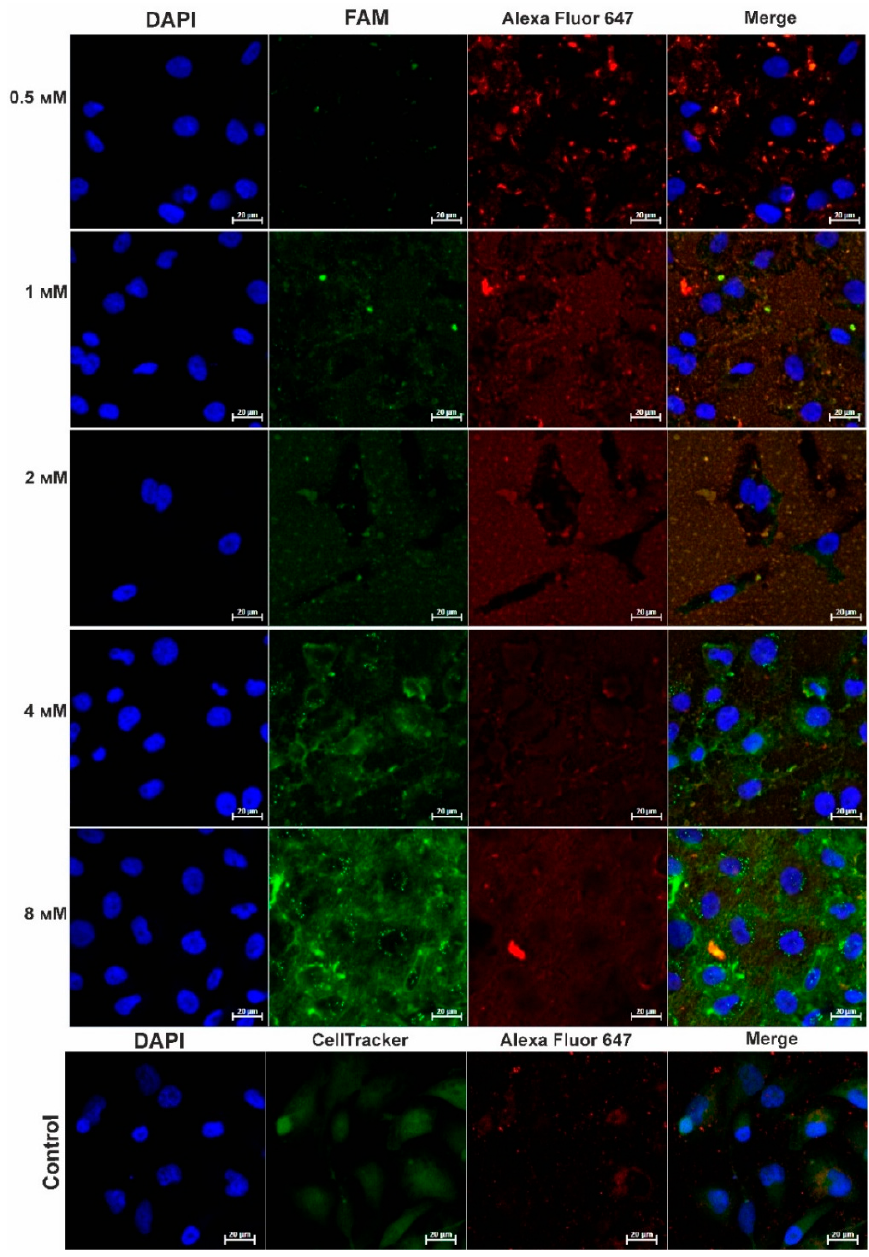
Figure 6. Penetration of bacteriophages M13-FAM and M13 (control) into MDA-MB-231 cells. Con- focal microscopy was performed using the system: primary antibodies to the pVIII protein of the M13 bacteriophage plus secondary antibodies to mouse IgG (H + L) conjugated to Alexa Fluor 647 (red channel, 633 nm). For visualization, nuclei were stained with DAPI (blue channel, 405 nm). M13-FAM bacteriophage corresponds to the green channel, 488 nm. Controls were stained with CellTracker™ Green CMFDA (green channel, 488 nm). Lens 63 × /1.40 Oil DIC